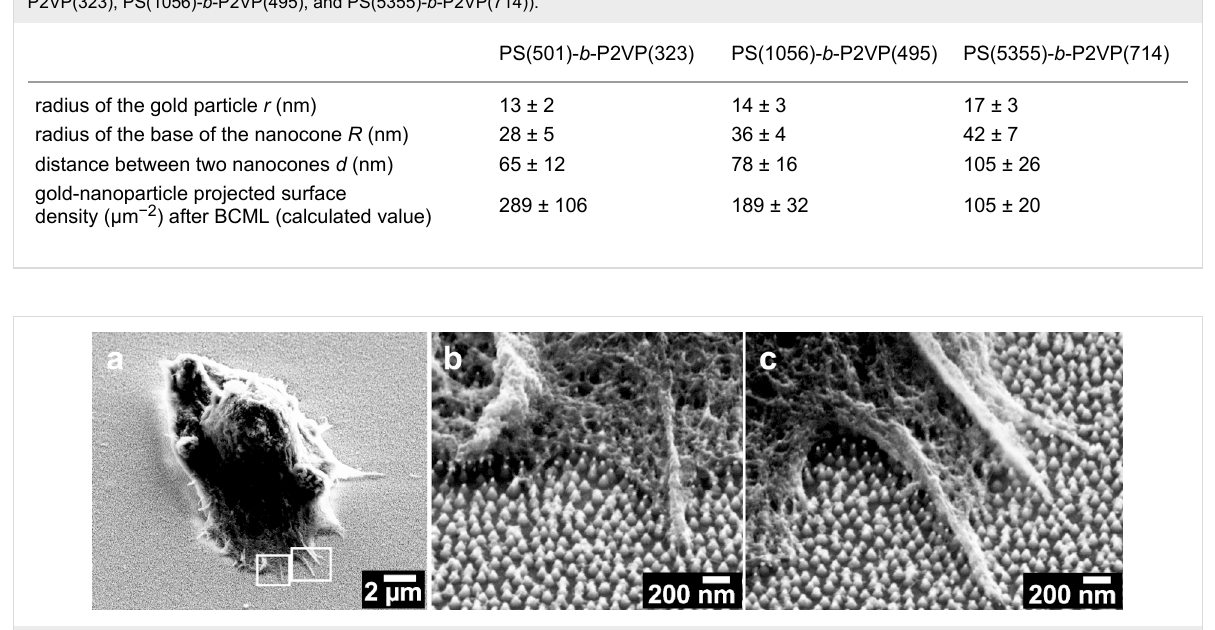
Figure 2: Scanning electron microscopy analysis (45° tilt) of adhering SHSY5Y human neuroblastoma cells. The figure shows a clear adhesion of cellular protrusions to the Au-tipped nanocones. Images were taken at different magnification with a SE2 detector.